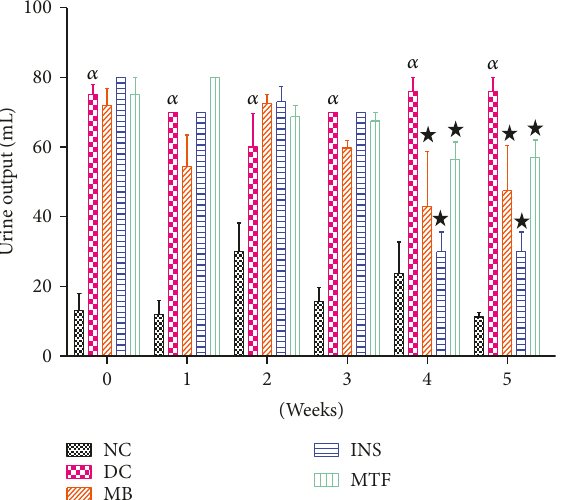
Figure 1: Mean arterial blood pressure of nondiabetic controls, diabetic controls, and diabetic rats treated with M. balsamina , metformin, and insulin over a period of 5 weeks. Values are expressed as mean ± SEM . α p < 0 05 by comparison to nondiabetic control; ★ p < 0 05 by comparison with diabetic control.